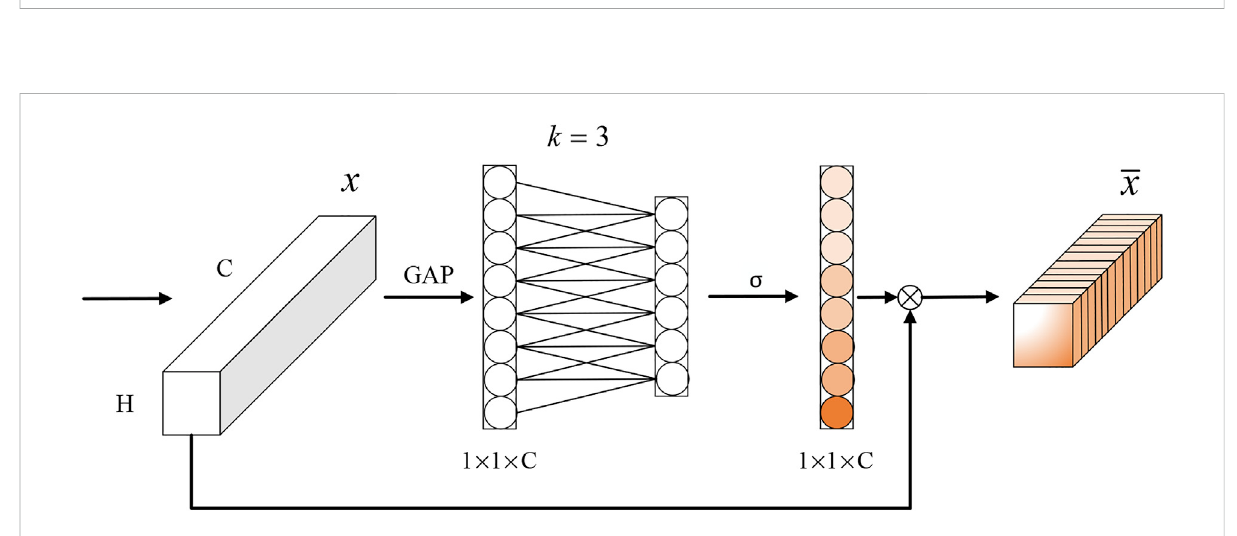
FIGURE 2 ECA attention module structure